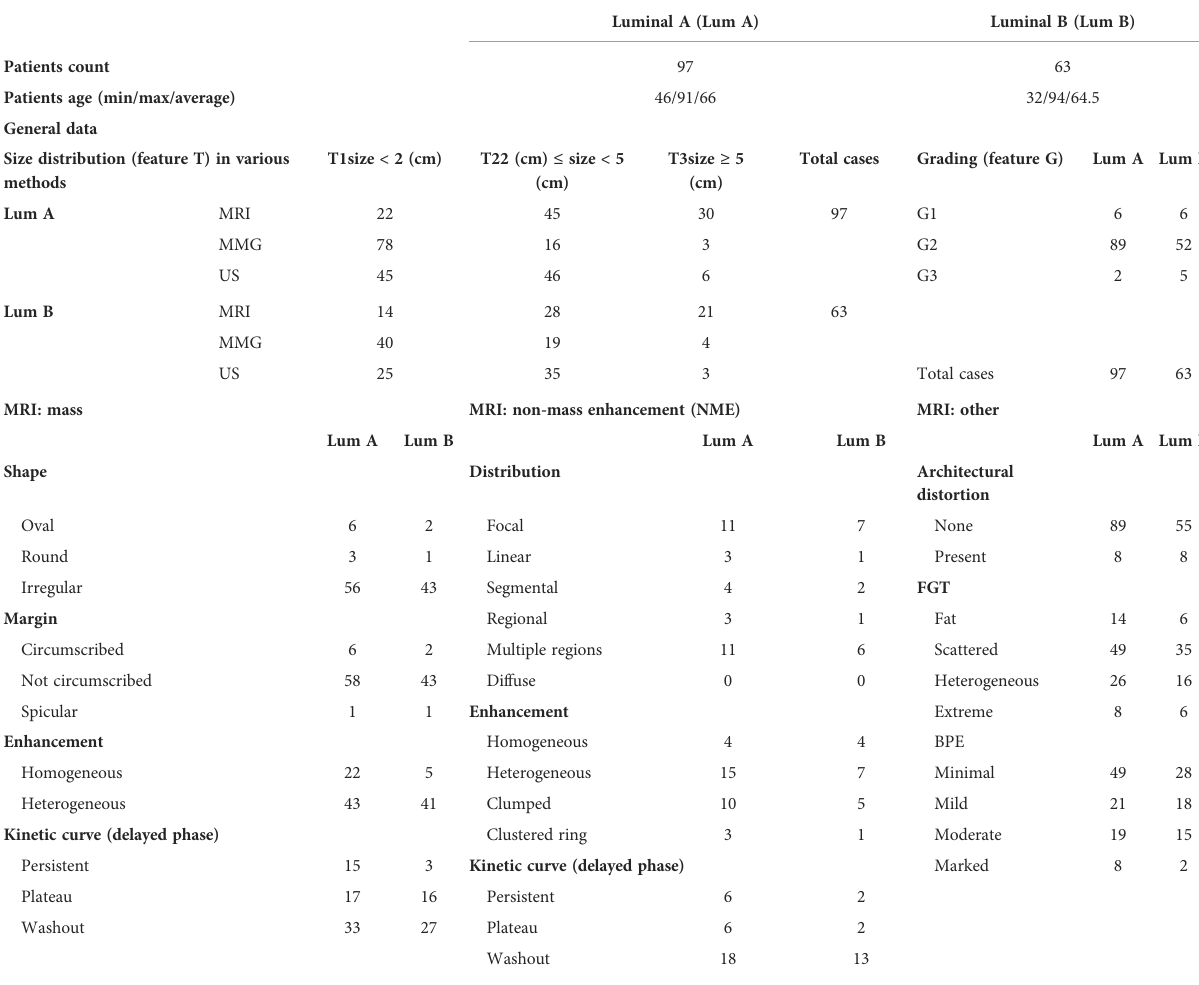
TABLE 4 Differences between luminal A and luminal B ILC